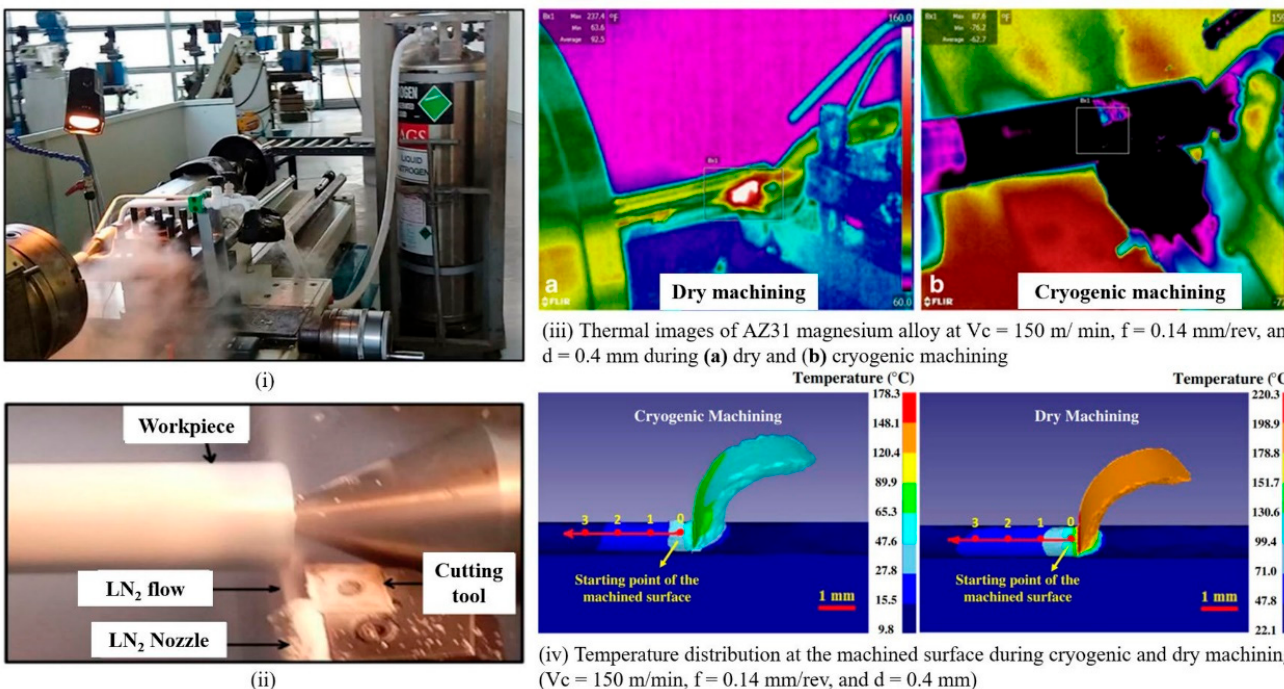
Figure 4. ( i ) Cryogenic turning setup, ( ii ) cryogenic turning, ( iii ) thermal images, and ( iv ) simulated results of the temperature distribution amid the turning of the Mg alloy AZ31 [70]. Reprinted from Int. J. Adv. Manuf. Technol., 91, Danish, M.; Ginta, T.L.; Habib, K.; Carou, D.; Rani, A.M.A.; Saha, B.B., Thermal Analysis during Turning of AZ31 Magnesium Alloy under Dry and Cryogenic Con- ditions, 2855–2868, 2017, with permission from Elsevier.